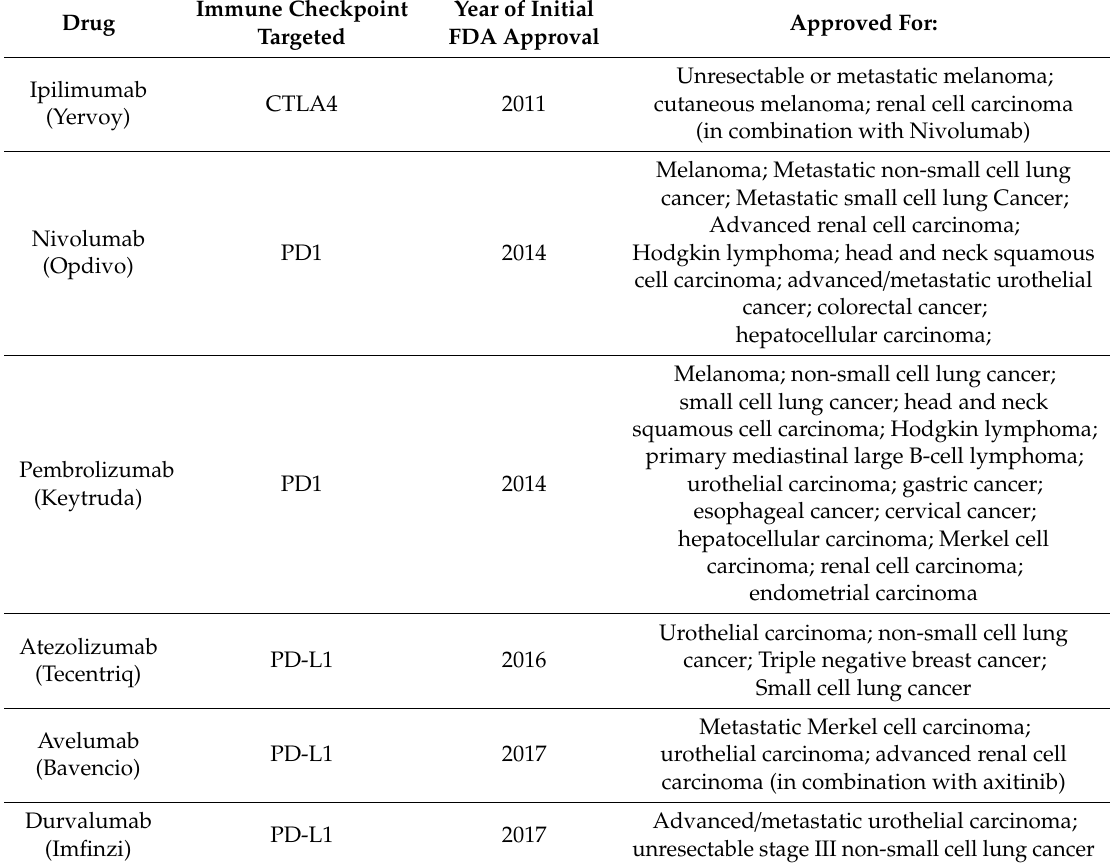
Table 1. FDA approved immune checkpoint